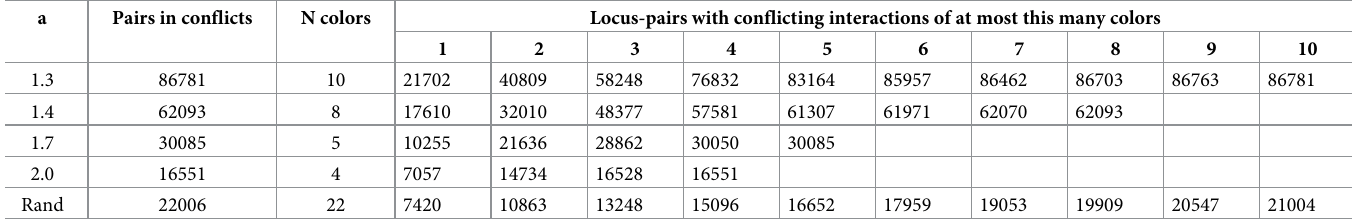
Table 2. Minimum numbers of colors (genome states) needed to reconcile the yeast HiC data, depending on the threshold of a in conflict definition (Eq